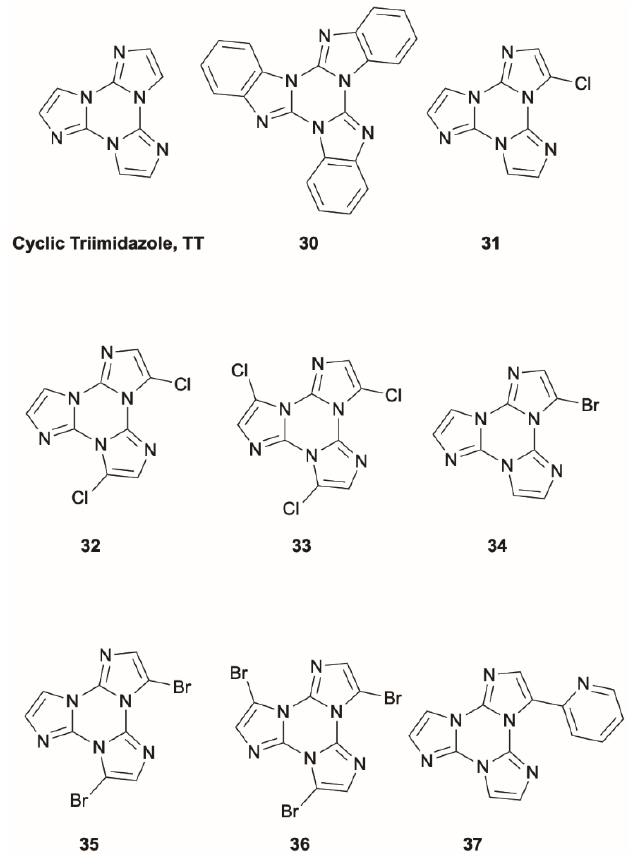
Scheme 10. Chemical structure of TT and compounds 30 – 37 .